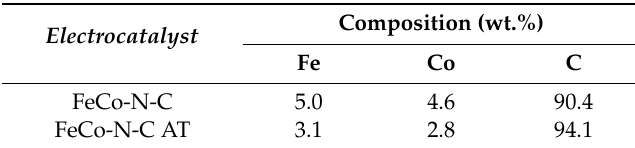
Table 1. The average percentage of elements investigated by EDX for the FeCo-N-C (as prepared) and Fe-Co-N-C AT (acid treated)